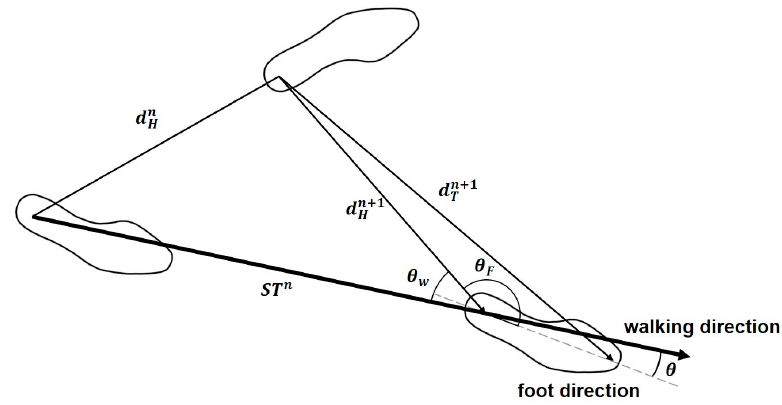
Figure 4. Schematic of foot progression angle definition.